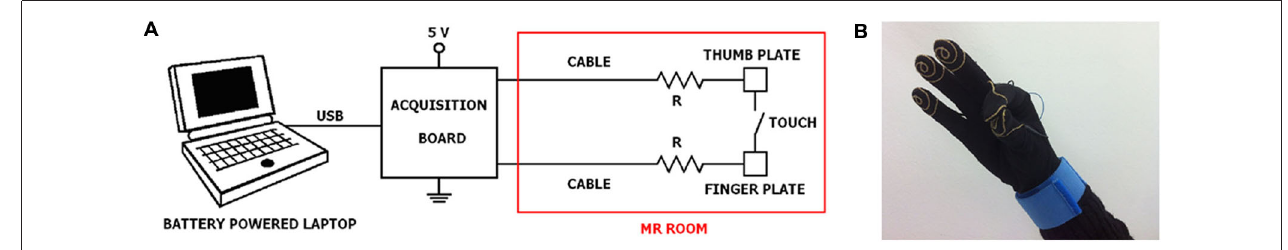
FIGURE 1 | Experimental set-up. (A) General connection scheme of laptop, acquisition board and engineered glove system; (B) a glove prototype with an example of thumb-to-index finger contact. It should be noted that a subdivision of the equipment in the portions that can be positioned outside and inside the MR room is